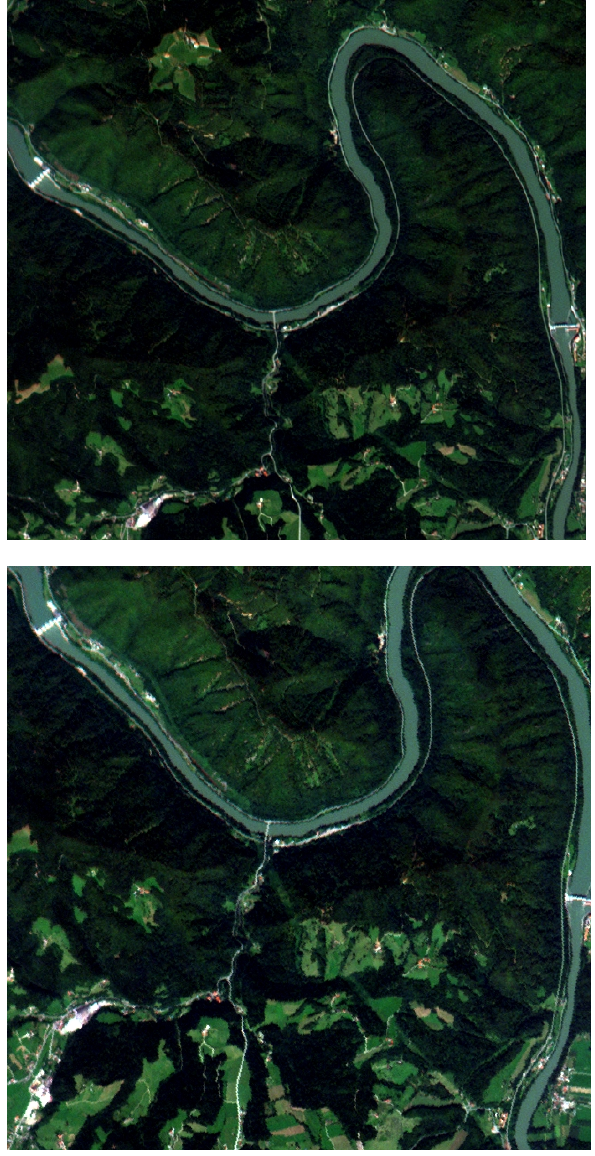
Figure 9. Comparison between RapidEye subsets before (above) and after (below) the orthorectification. On the corrected image the rotation and translation of the terrain can be